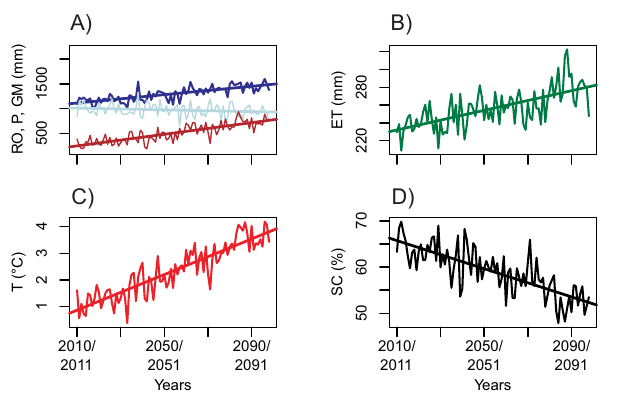
Fig. 2. Time series of annual areal terms of (A) runoff (RO, blue), precipitation ( P , lightblue) and glacier melt (GM, brown), (B) evap- otranspiration (ET, green), (C) temperature ( T , red) and (D) frac- tional snow coverage (SC, black) calculated using downscaled cli- mate scenario data. Fig. 3. Box plots of monthly areal values (A) of runoff (RO),